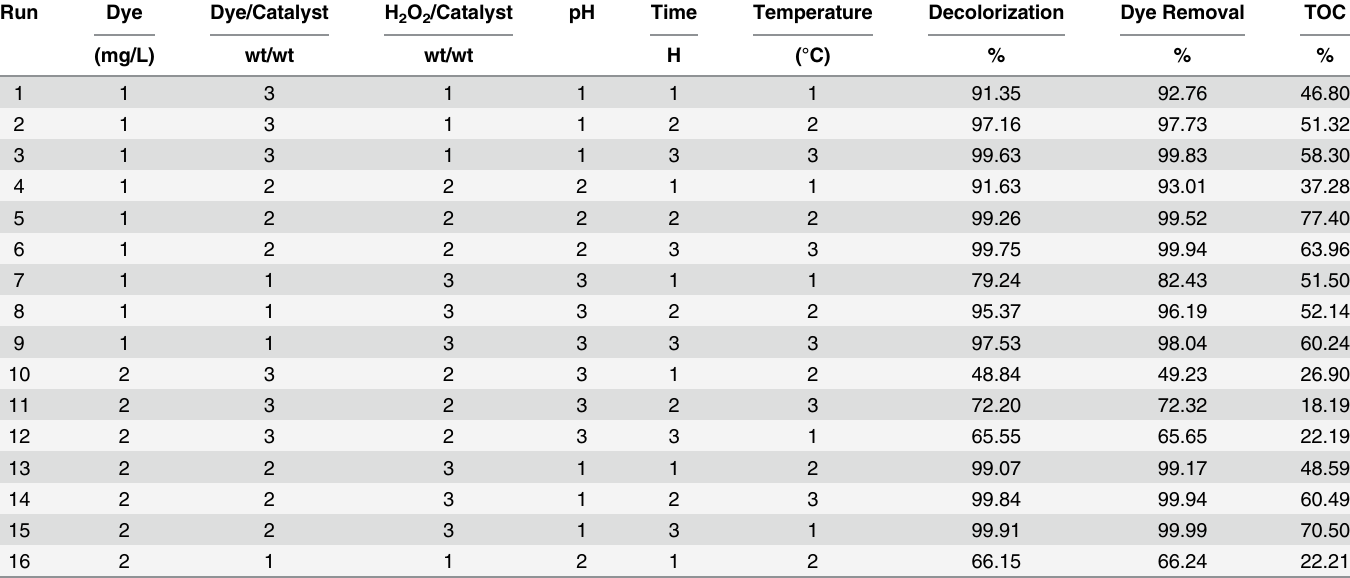
Table 4. L 27 orthogonal design, experimental results, and Taguchi analysis for run 1 to 16, Run